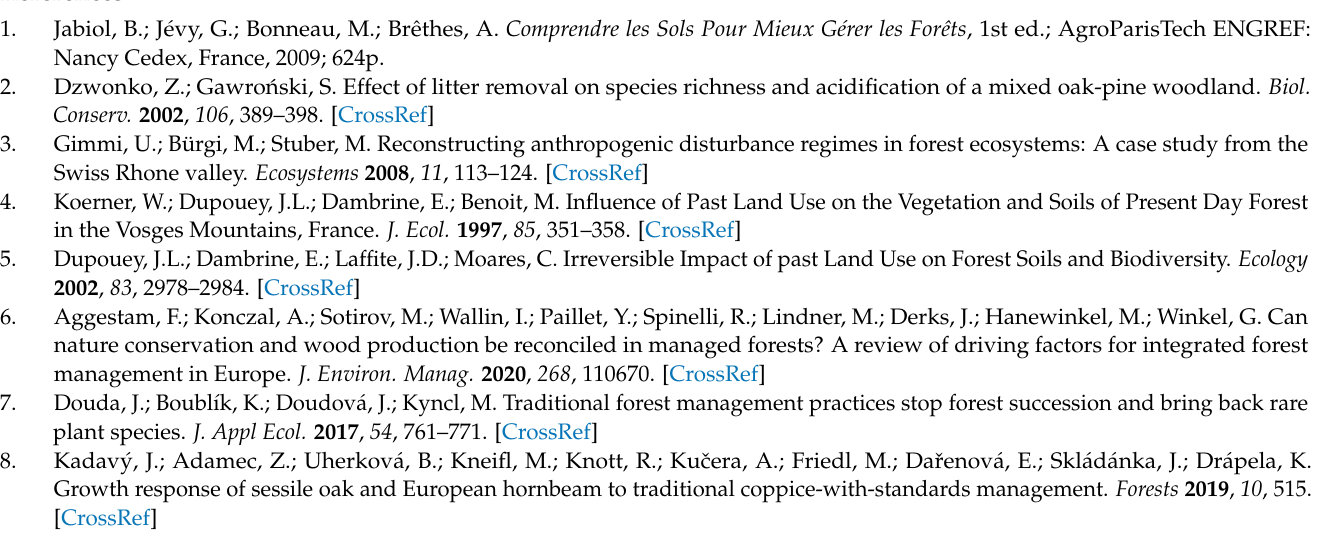
Figure S2: Shannon–Wiener diversity index values within treatments as a function of carbon